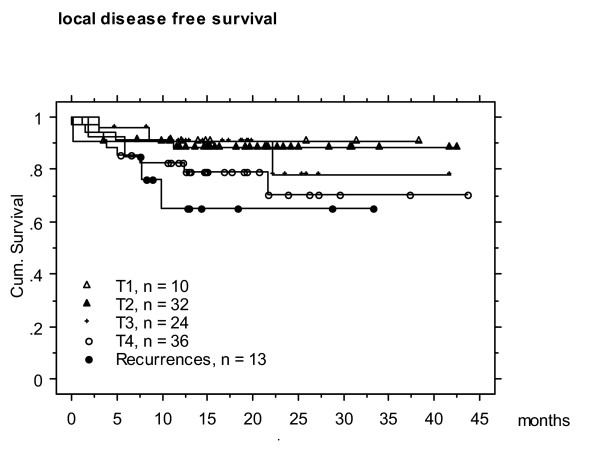
Actuarial 2 year local disease free survival according to the T-stages.